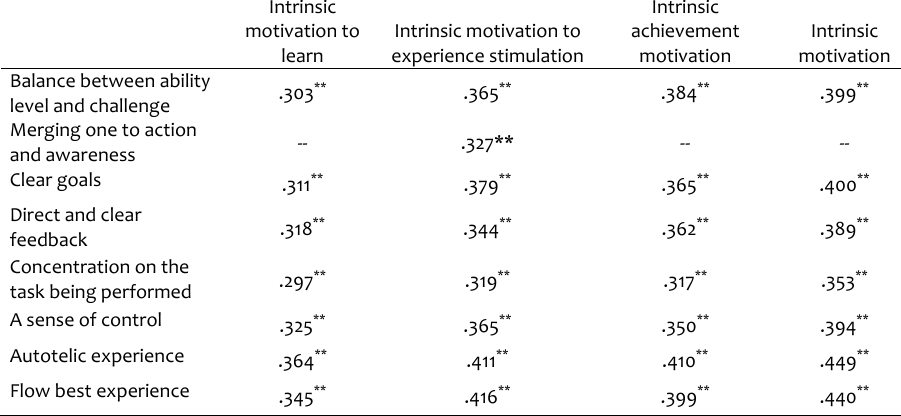
Table 7. Correlations between intrinsic motivation and Flow State for teachers.